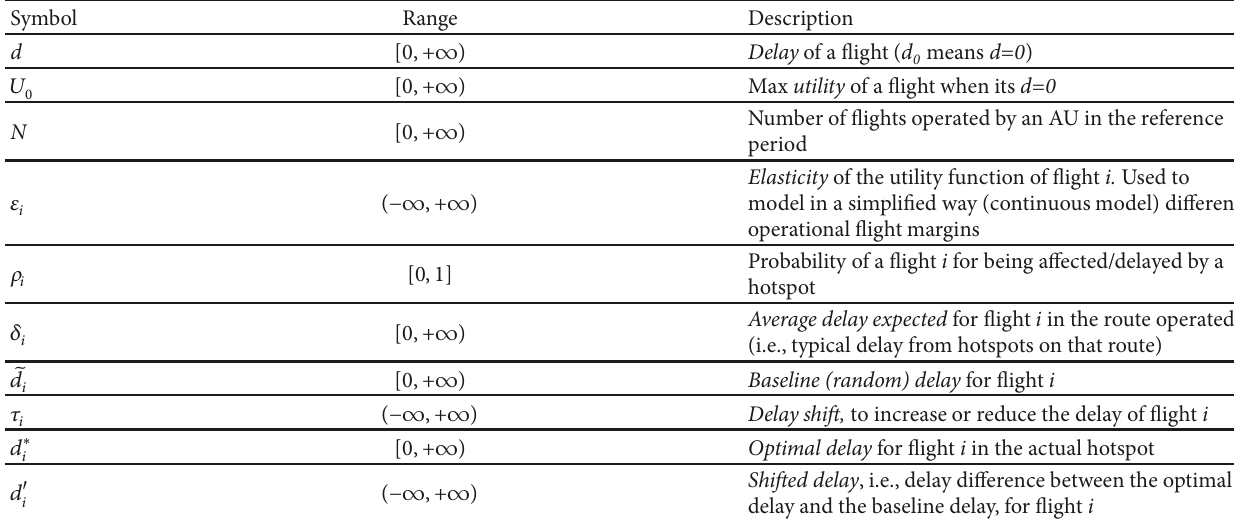
Table 10: Description of model parameters and variables.